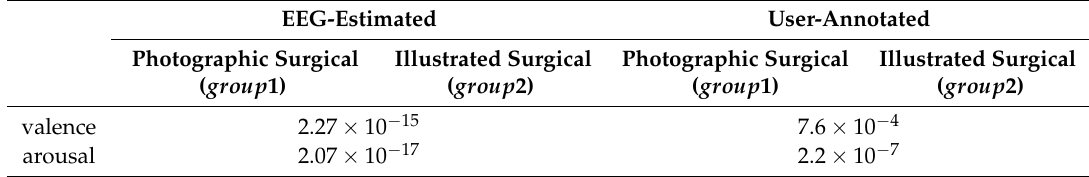
Table 3. p values for t -test between photographic and illustrated surgical images. EEG-Estimated User-Annotated Photographic Surgical Illustrated Surgical Photographic Surgical Illustrated Surgical